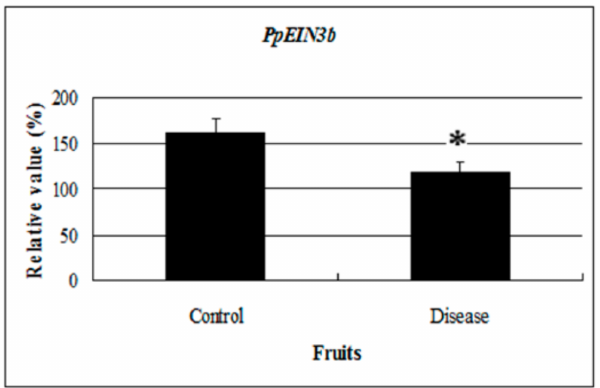
Figure 8. qRT-PCR analysis of PpEIN3b expression in diseased fruit. Relative values of PpEIN3b expression in diseased fruit 20 days after harvest are shown as percentage of PpUBI expression.